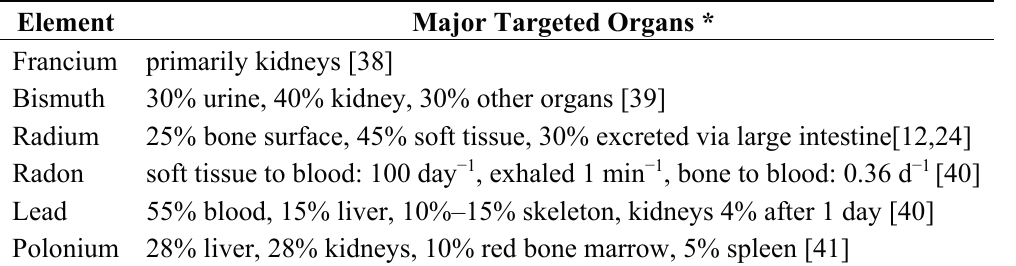
Table 2. Major targeted organs based on 24 h distribution after intravenous injection